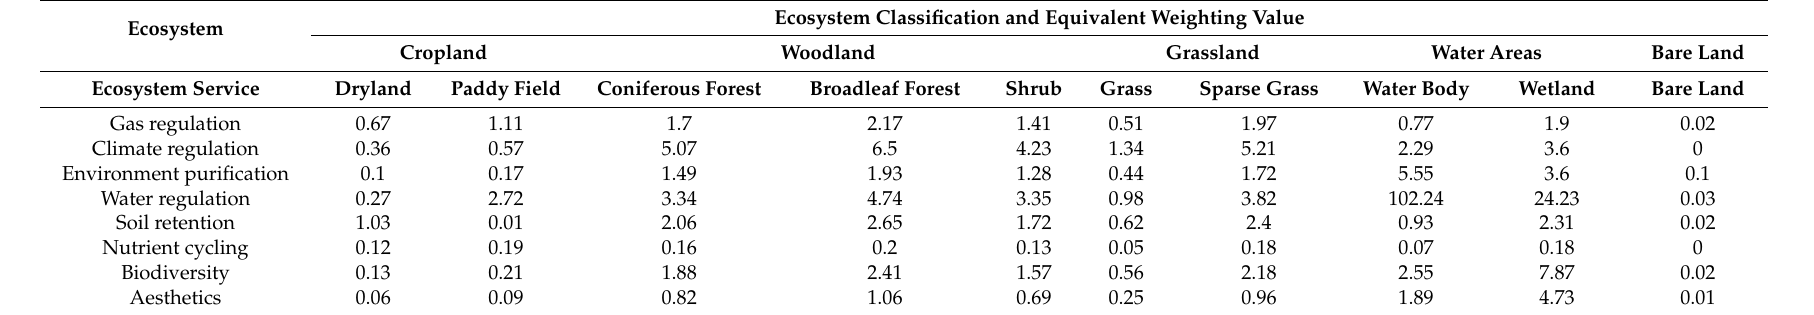
Table 1. Ecosystem classification and equivalent weighting values for ecosystem services